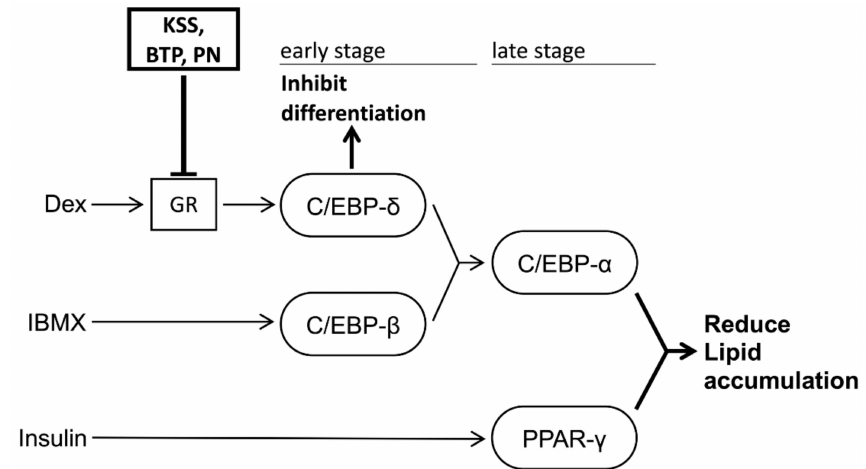
Figure 8. KSS, MC, and PN suppress lipid accumulation by suppressing Dex-induced GR activation and controlling early di ff erentiation in 3T3-L1 cells. 3T3-L1 cells are di ff erentiated into mature